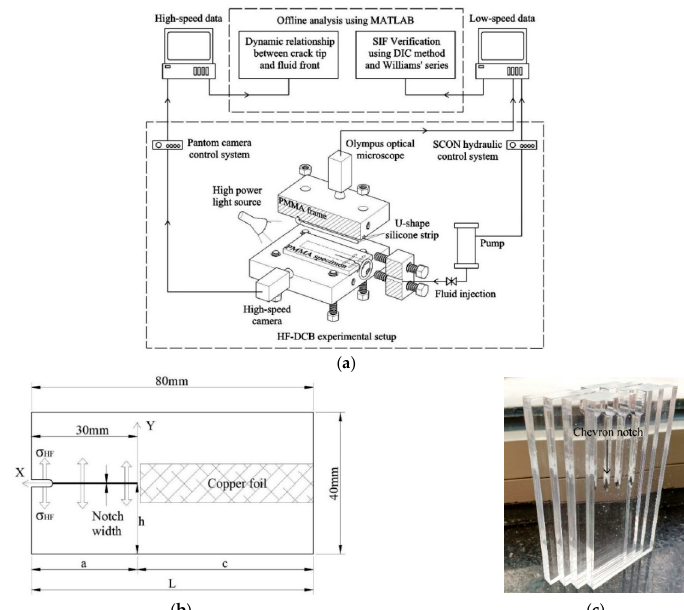
Figure 1. The experimental setup and specimen configuration. ( a ) Laboratory-scale hydraulic fracturing device. The high-speed camera direction is parallel to the specimen surface and the optical microscope direction is perpendicular to the specimen surface. Both the specimen and frame are transparent; ( b ) Configuration of the hydraulic fracture in double-cantilever-beam (HF-DCB) specimen. The to-be-fractured area is pasted with 0.05 mm thin copper foil to avoid side flow; ( c ) HF-DCB with intrinsically sharp crack tip induced by Chevron notch.